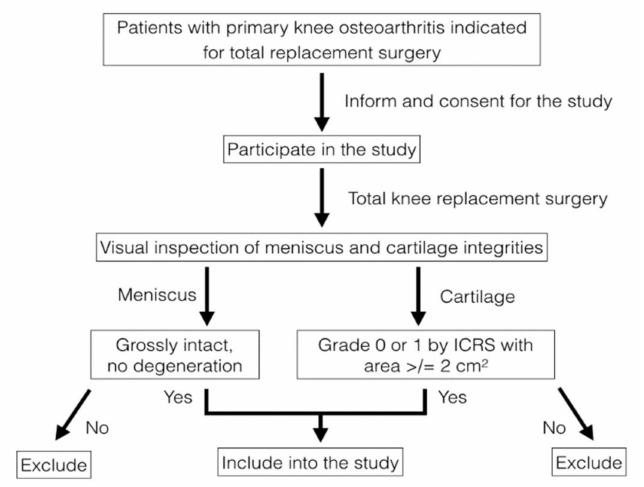
Figure 1. Flowchart of the sample collection. The menisci and femoral condyles of the patients who met the criteria and volunteered to join the study were visually inspected; only patients who had non-degenerative meniscus and spared at least 2 cm 2 of grade 0 and 1 cartilage by ICRS grading were included in the